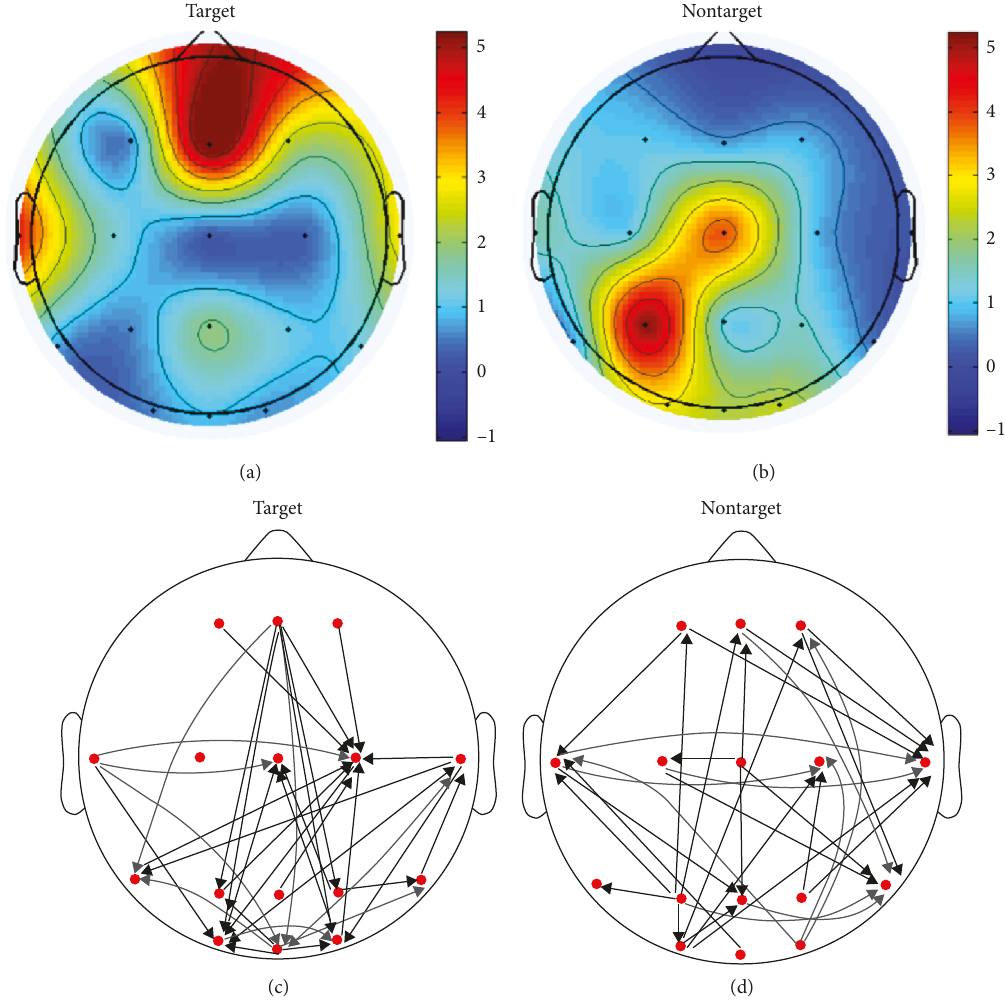
Figure 4: Flow gain mappings of one typical subject in response to target (a) and nontarget (b). One subject ’ s e ff ective connection patterns of target (c) and nontarget (d) condition. The arrows stand for information fl ow direction. For better illustration purpose, only the top 15% of the maximum edges are shown. Table 1: Comparisons of the graph measures between target and nontarget condition based on a sparsity method. Graph